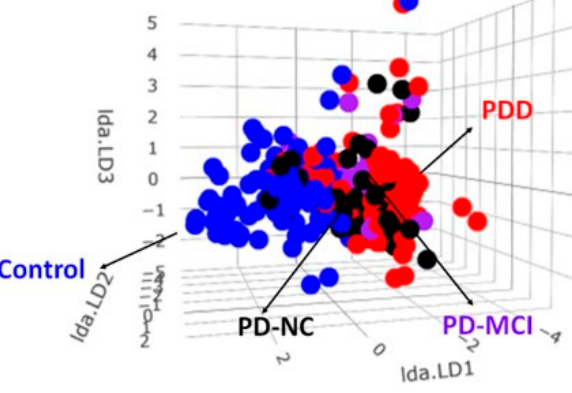
Figure 7. The 3D scatter plot demonstrates that LDA separated sample points of different subgroups of the PD spectrum.